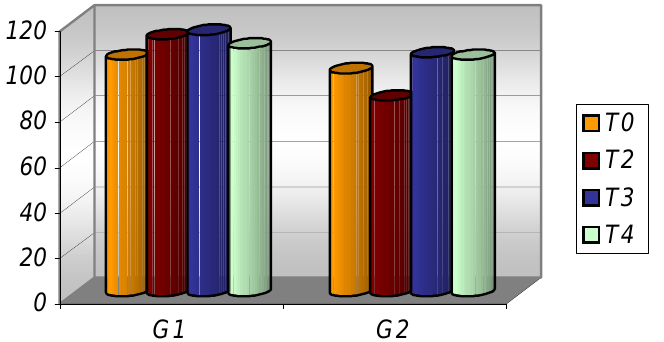
Figure 3: Comparison of the variation on the average of the cardiac frequency values between the two groups observed (G1 = 0.25 mg/kg and G2 = 0.4 mg/animal) at the four different moments studied (T0 = pre-envenomation; T2 = 6h after envenomation; T3 = 24h after envenomation; and T4 = 72h after envenomation). Botucatu, São Paulo, Brazil,